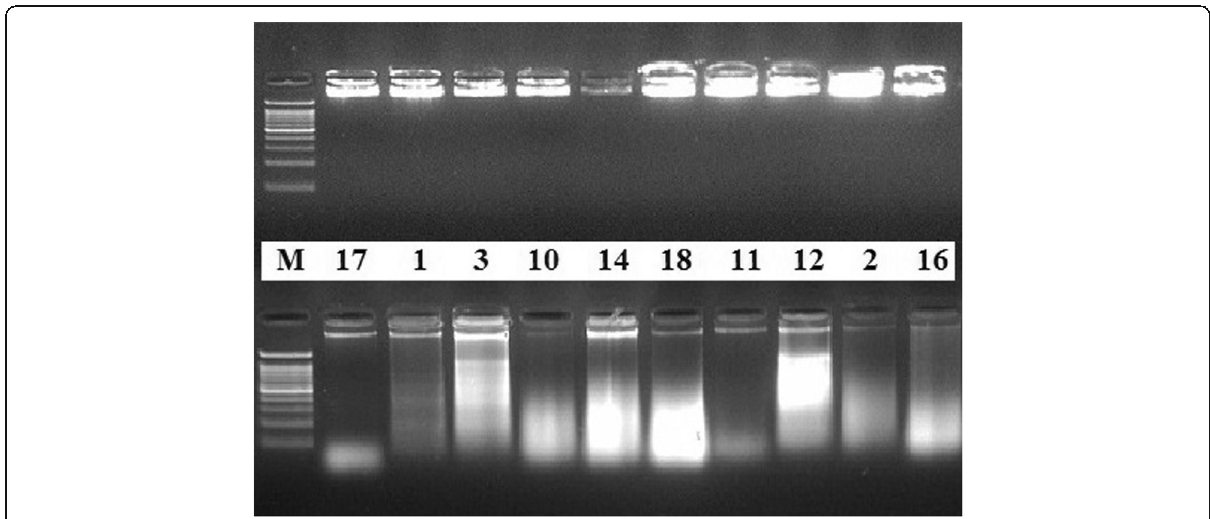
Fig. 1 Quality of extracted DNA. Quality of DNA extracted from some of the plant samples using both DNA extraction methods. Electrophoresis separation was performed on 0.8% agarose gel matrix, stained with ethidium bromide. The upper lane is for samples extracted by the standardized method after modification; the lower lane is for the same samples extracted by the conventional method. M is a molecular marker (100